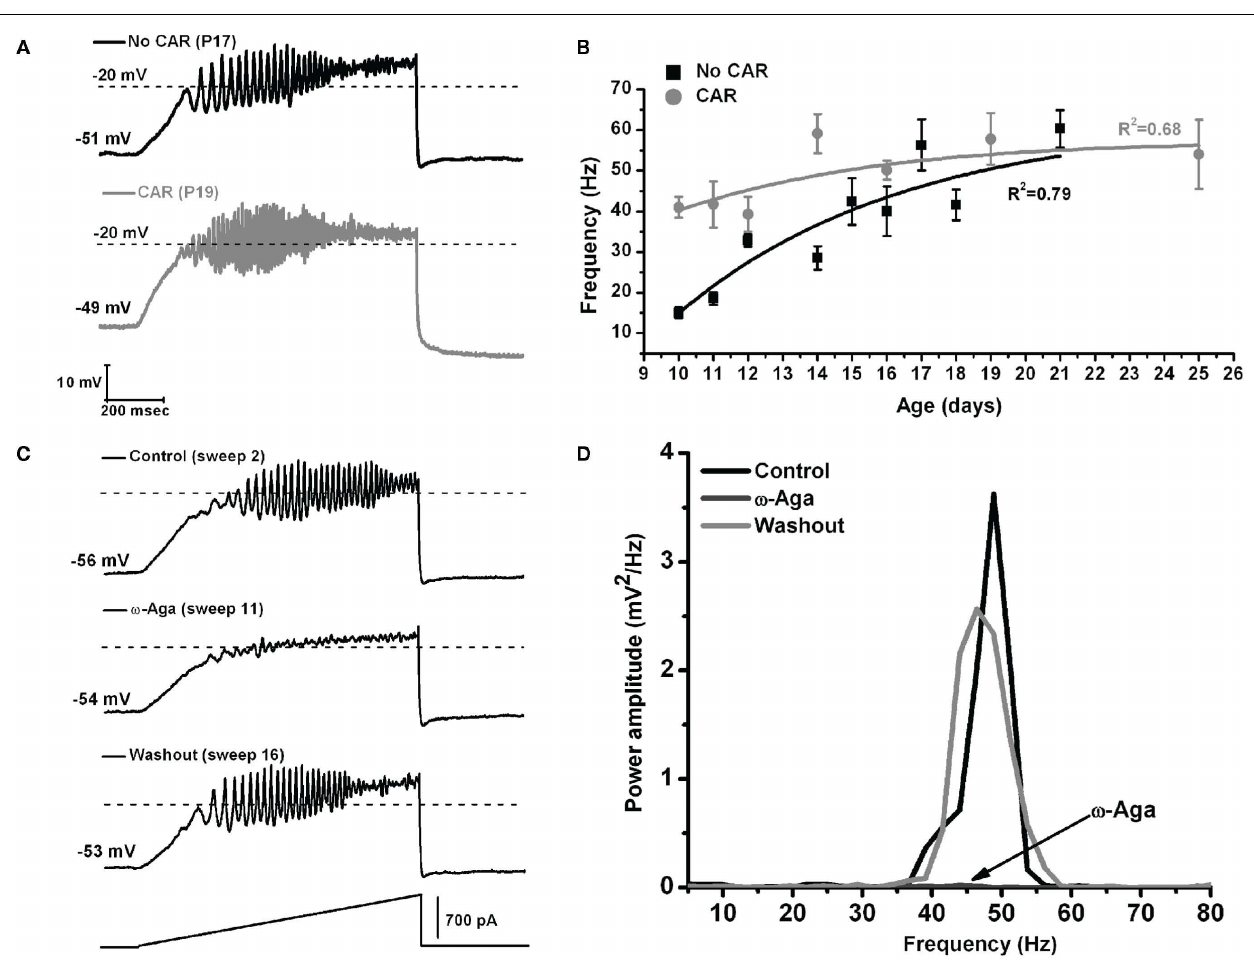
and gray (CAR) lines represent the best-fit lines of the corresponding data. (C) Representative membrane potential oscillations obtained during 1s long ramps before application of the specific calcium channel blocker (top record), after bath application of ω -Aga (200nM; middle record), and after washout (bottom record). Note the elimination of oscillations by the P/Q-type channel blocker ω -Aga, and the return of the oscillatory activity, after only 5min of washout. (D) Power spectrum of the records shown in (C)